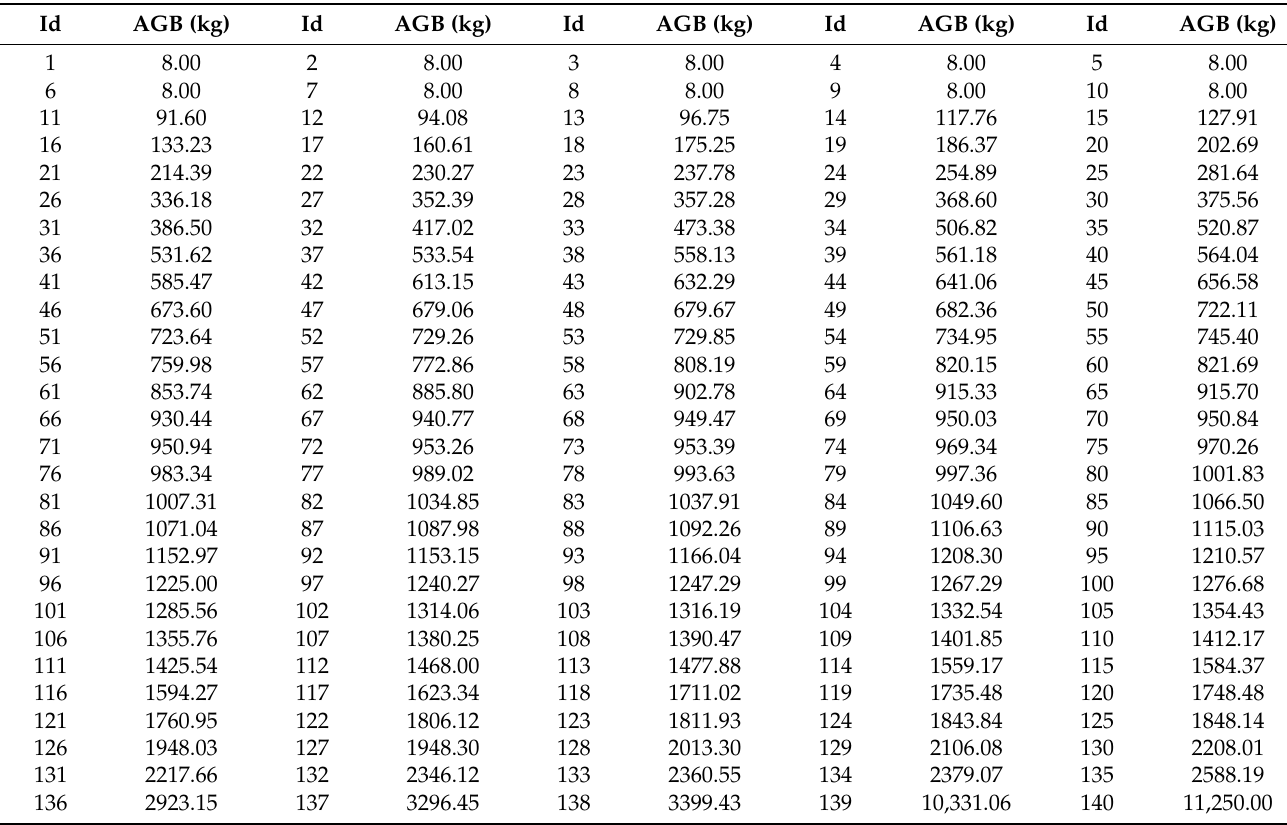
Table A3. The above-ground biomass measurements for 140